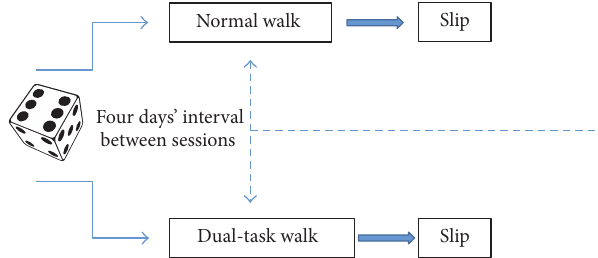
Figure 2: Participants were assigned to normal or dual-task session randomly and the listed tests were